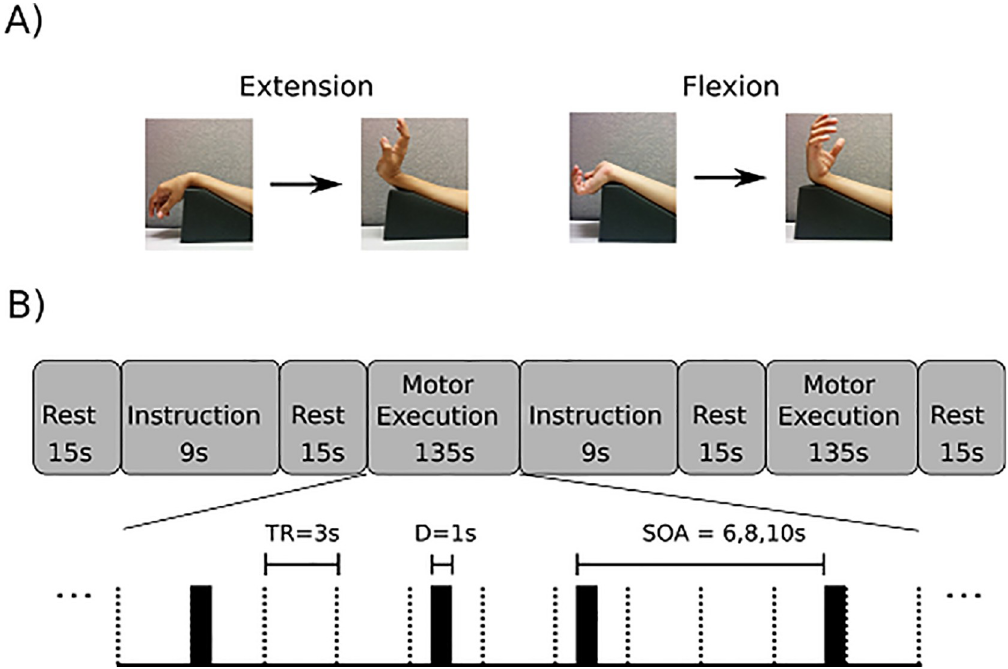
Fig 1. Study design. Panel A. Arm positions used for wrist extension and wrist flexion movements. Right wrist extension executed against gravity: The forearm was pronated and a foam wedge positioned the elbow flexed 30 deg. Right wrist flexion against gravity: The forearm was supinated, with the elbow positioned in 30 degrees of elbow flexion. Each repetition of the motor task was cued by the word “Go” appearing on the screen, and the movement end-point (e.g., full wrist extension) was instructed to be held for 1 sec, after which time the instruction on the screen changed to a fixation figure, and the participant lowered the hand to the start position. Panel B. Blocked data acquisition design, with each movement cued within a given block, for one run of the wrist movement task. The upper part of panel B shows the sequence of rest, instruction, and execution periods. The lower part of panel B shows a detailed subsample of a motor execution series on an expanded time scale. In this subsample, movement events are cued at pseudo-random